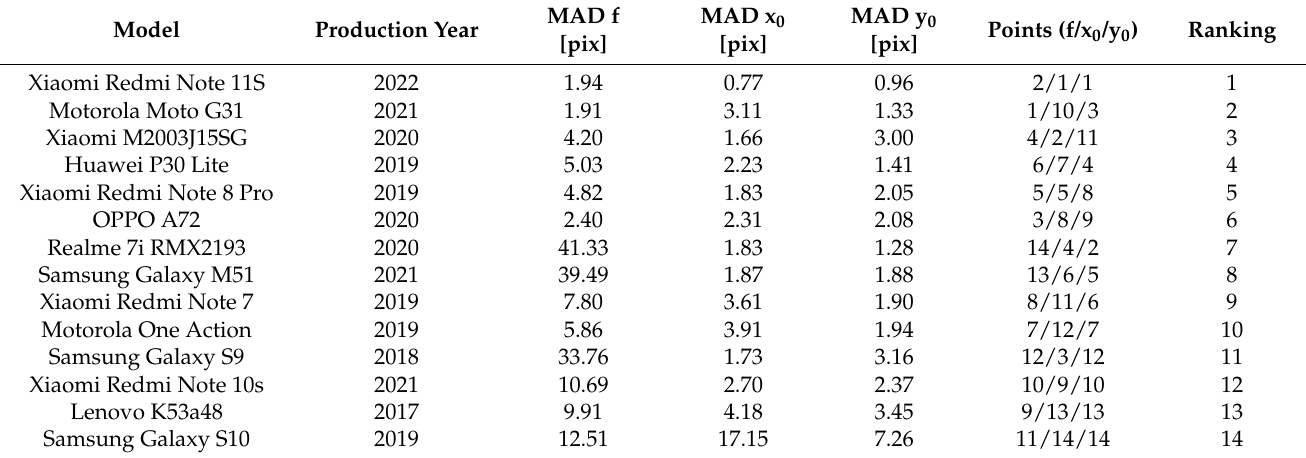
Table 3. Stability ranking for the tested SPCs.